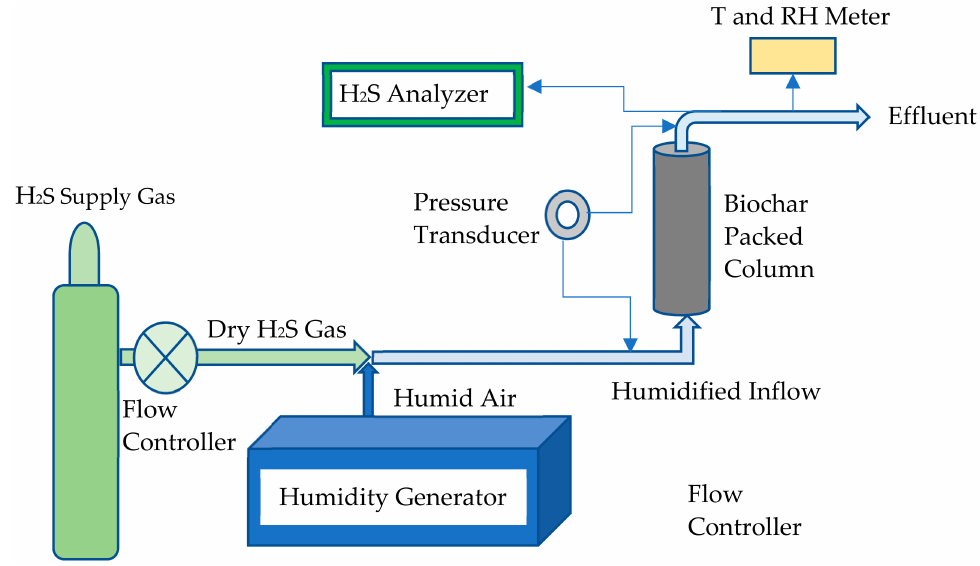
Figure 1. Bench-scale biochar